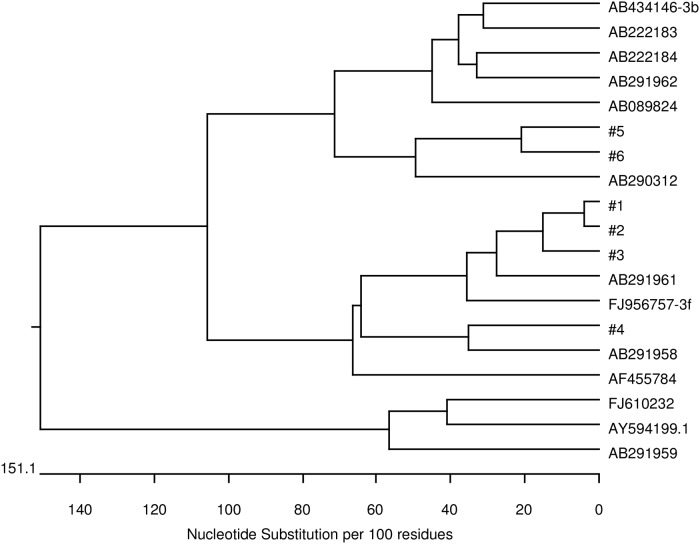
Phylogenetic relationship between genotype 3 HEV strains derived from Austrian blood donors (#1–6) and HEV reference strains (GenBank sequences are cited by their respective accession numbers).The tree was constructed by the Clustal W method on the basis of a 304-nt sequence fragment of ORF2 region.